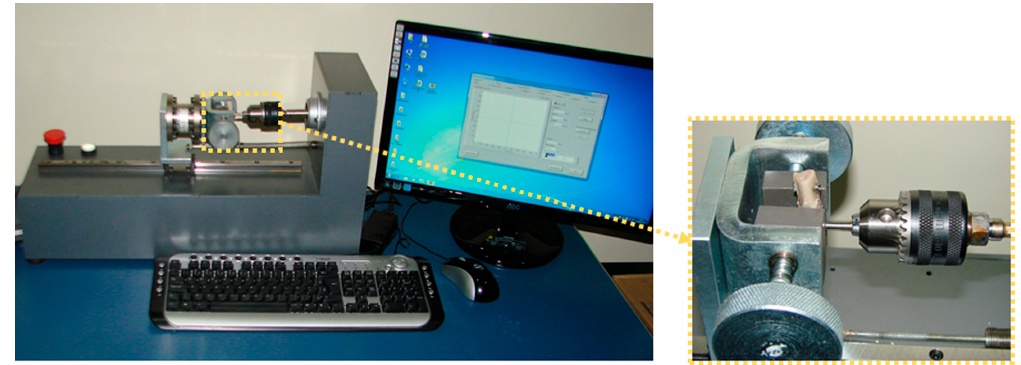
Figure 3. Image of the torque machine used to measure the removal torque value of the samples.